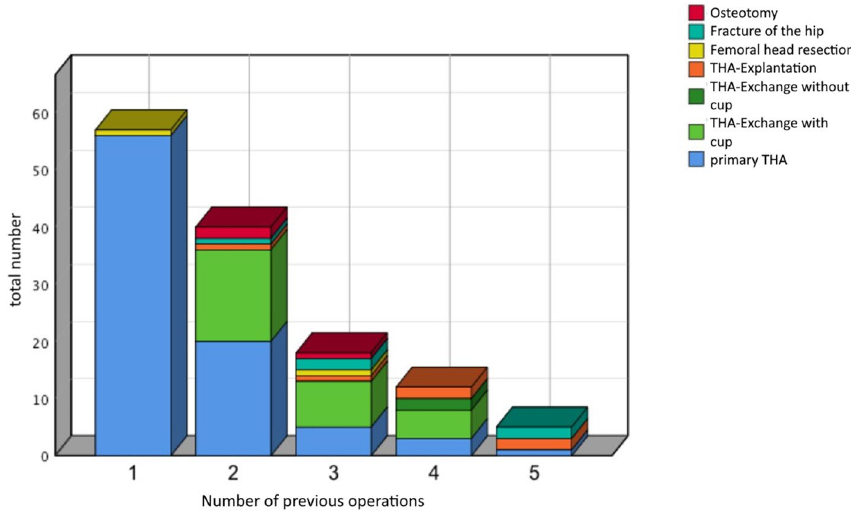
Figure 2. Previous operations before study index operation.